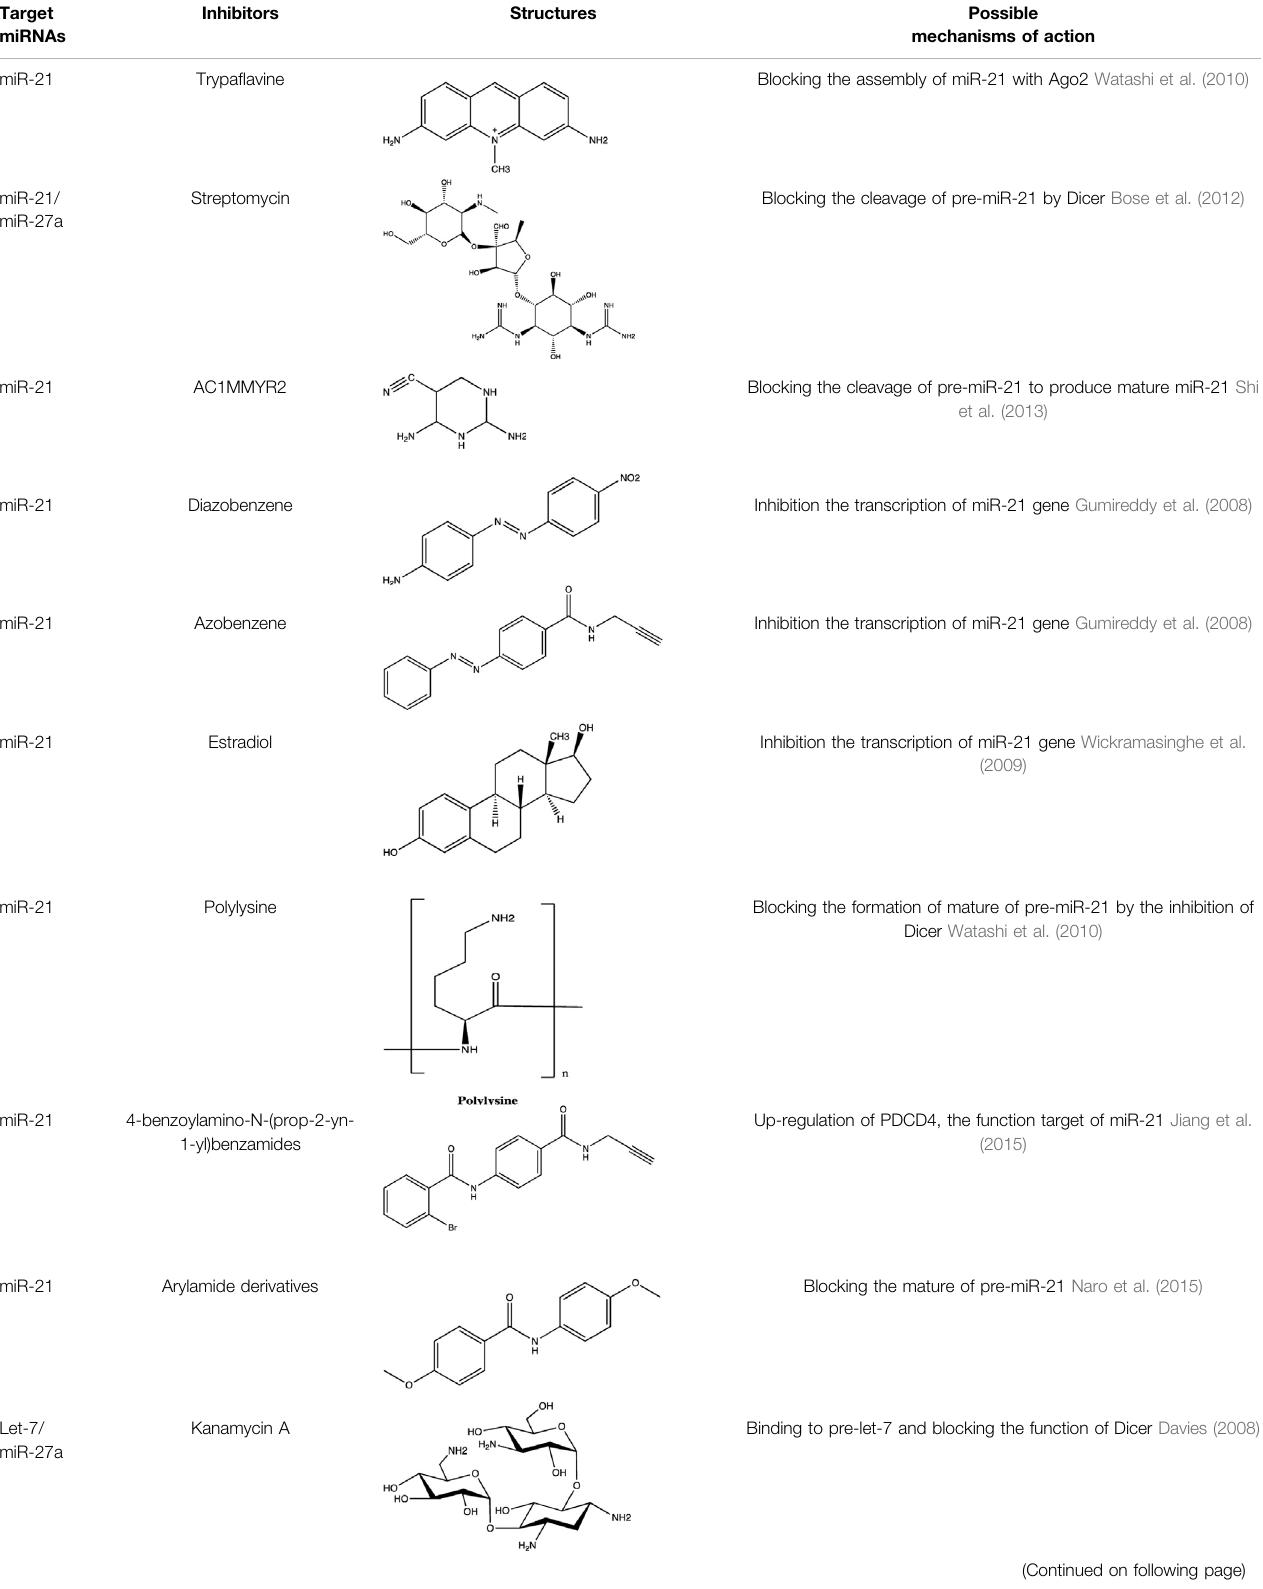
TABLE 4 | The summary of some representative small-molecule miRNA